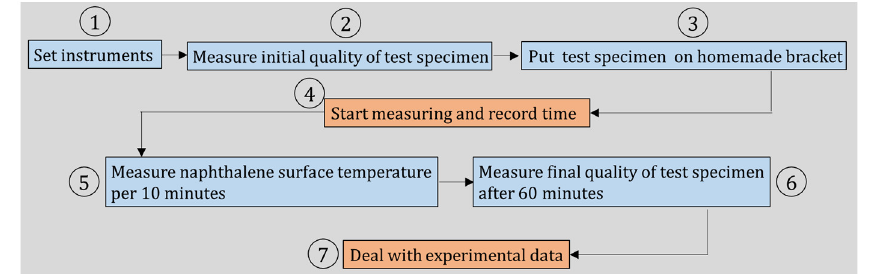
Figure 3. Steps of the naphthalene sublimation experiment.